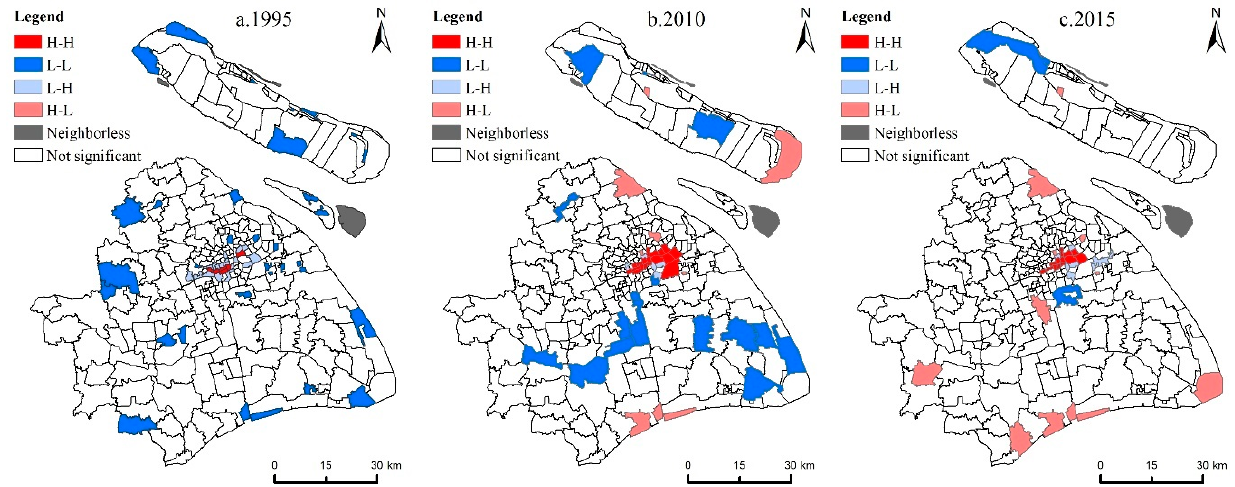
Figure 6. LISA spatial cluster map of all luxury hotels in Shanghai. Table 4. Moran’s I index for luxury hotels in Shanghai.